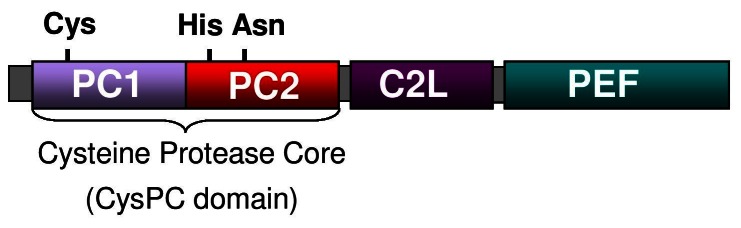
The schematic structure of calpain.Classical calpains, which include CAPN1, 2, 3b, 8, 9 11, 12, 13, 14, consists of two protease core domains (PC1 and PC2), a C2 like domain (C2L) and a penta EF-hand domain (PEF). The PC1 and PC2 make up the cysteine protease core. All calpains have a protease core domain, but the other domains differ in arrangement for the non-classical calpains.